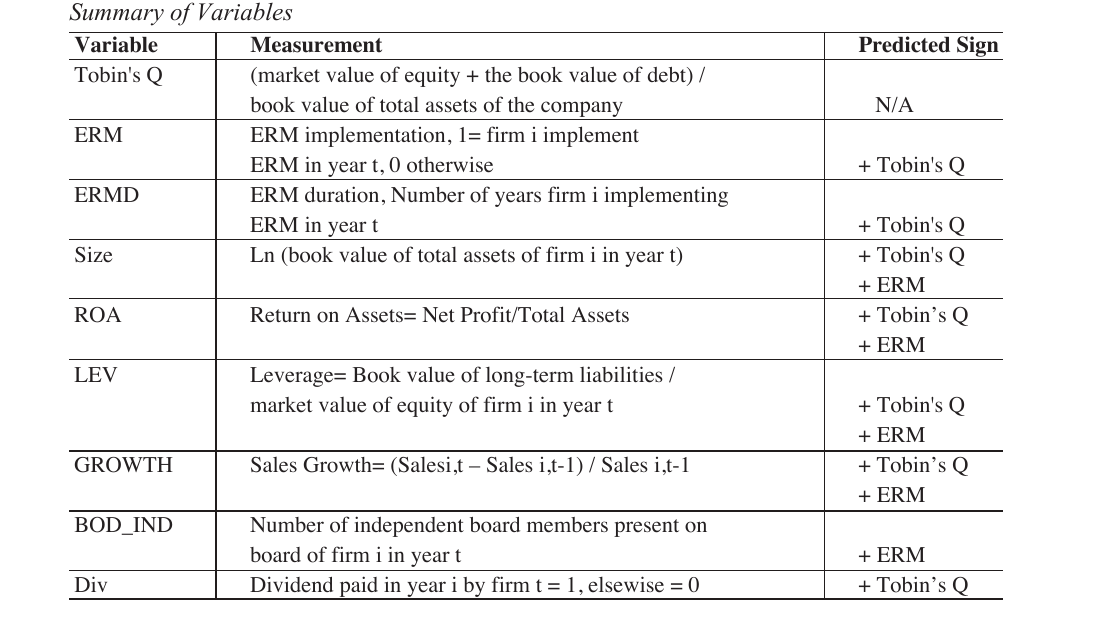
Summary of Variables